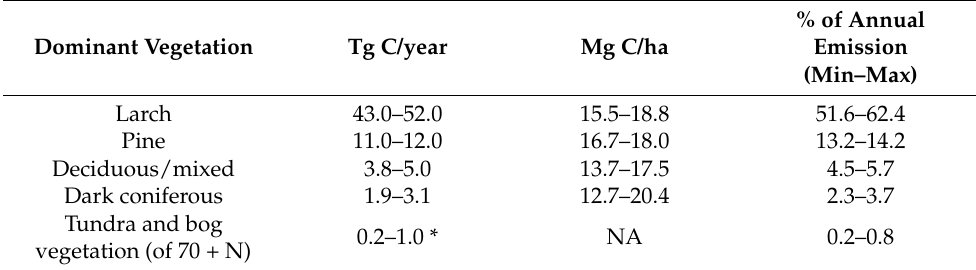
Figure 5. Annual data on wildfire emissions from fires in Siberia for 2002–2020 and current trends of emission: ( 1 ) estimated values and trend for sporadic maximum emissions, ( 2 ) estimated values and trend for minimum emissions, and ( 3 ) estimated values and trend for emission values without including extremes. Table 4. Estimates of carbon emissions per year (Tg C/year) and per area of forest (Mg C/ha) by vegetation cover types (range for moderate and extreme fire